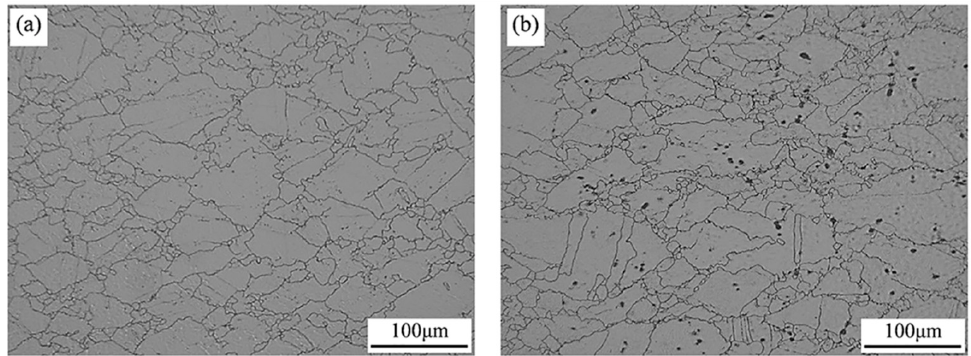
Figure 5. Microstructure of S280 steel at different deformation temperatures when the strain rate was 0.01s − 1 and the strain was 0.22: ( a ) 1100 °C; ( b ) 1150 °C.